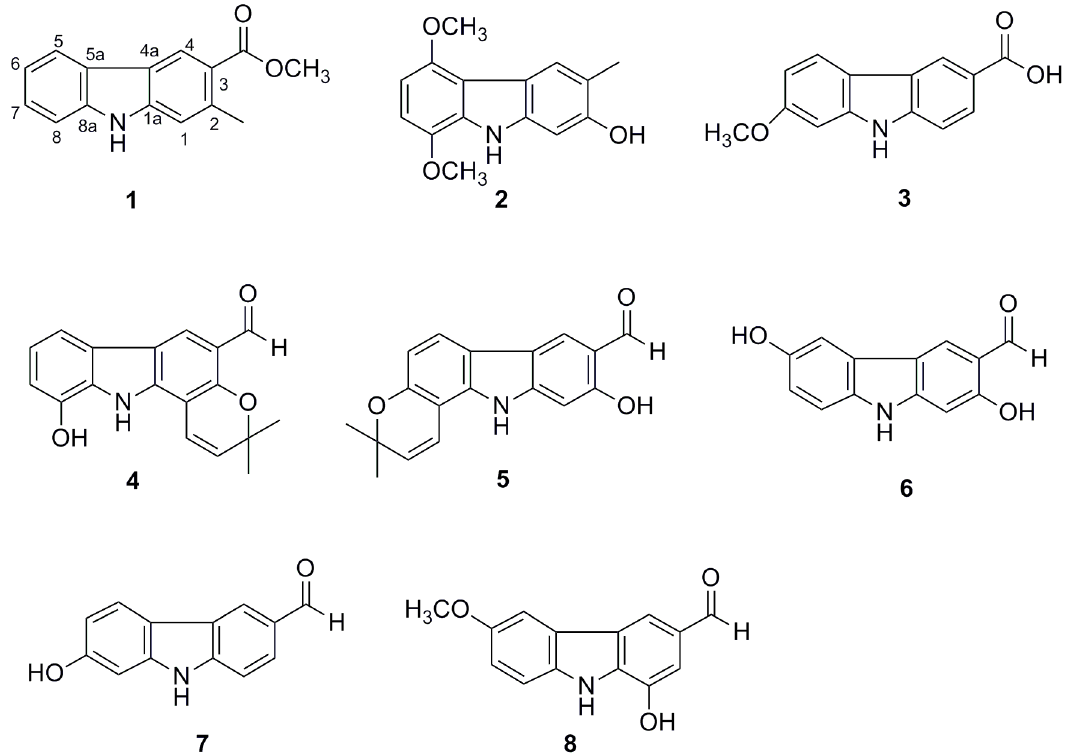
Figure 2. Structures of compounds 1 – 8.